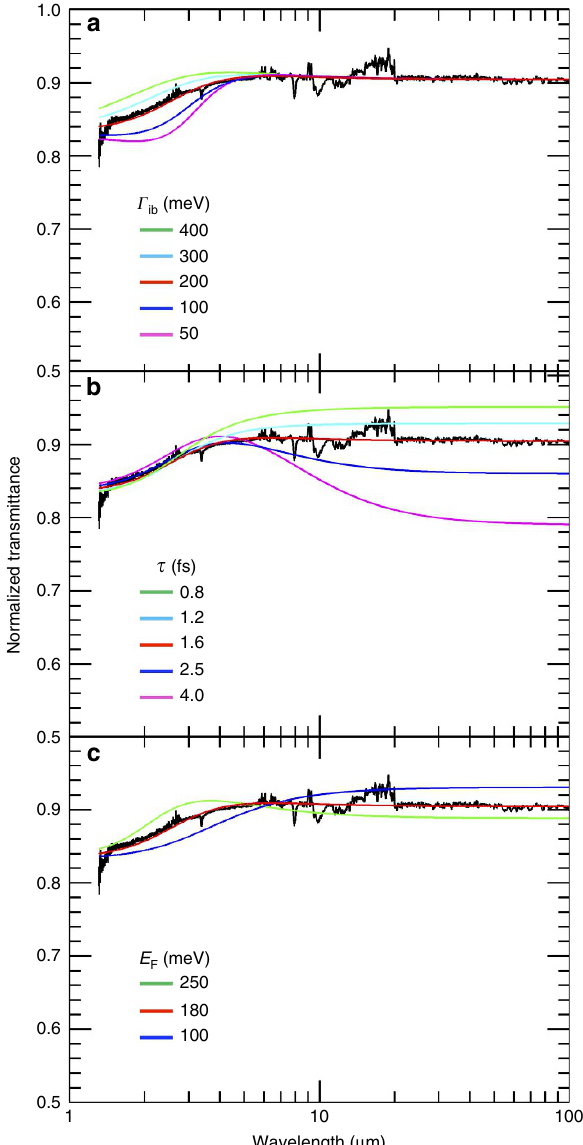
Figure 6 | Analysis of the FTIR spectra of ethanol-based graphene saturable absorber (Eth-GSA). ( a ) Dependence on G ib . FTIR transmission spectrum superimposed to fit function ( G ib ¼ 200meV, red line) and a set of functions obtained by varying G ib in the range 50–400meV. ( b ) Dependence on t . FTIR transmission spectrum superimposed to fit function ( t ¼ 1.64fs, red line) and a set of functions obtained by varying t in the range 0.8–4.0fs. ( c ) Dependence on E F . FTIR transmission spectrum superimposed to the fit function ( E F ¼ 181meV, red line) and a set of functions obtained by varying E F in the range 100–200meV.